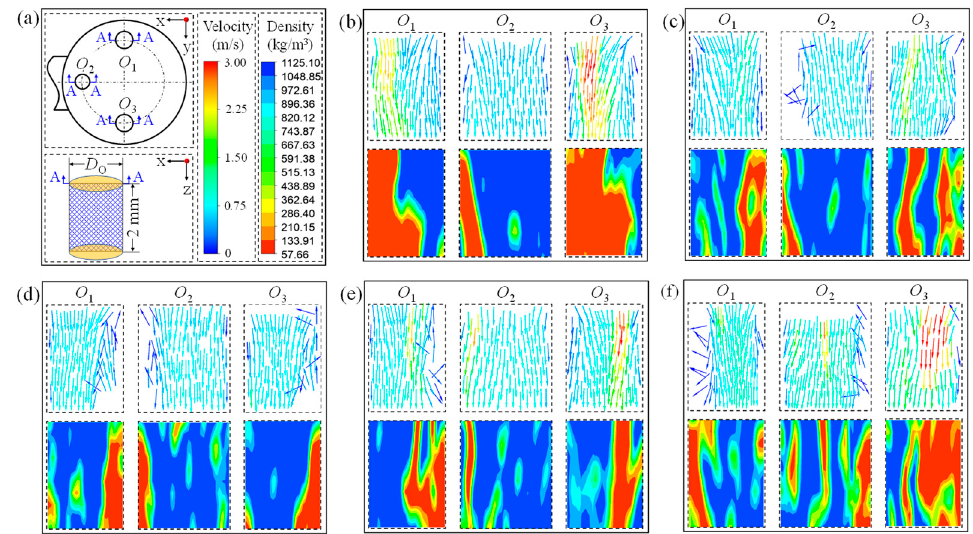
Figure 6. ( a ) Instructions and distributions of velocity and density in each orifice at ( b ) 9 g/s, ( c ) 12 g/s, ( d ) 15 g/s, ( e ) 18 g/s and ( f ) 21 g/s.